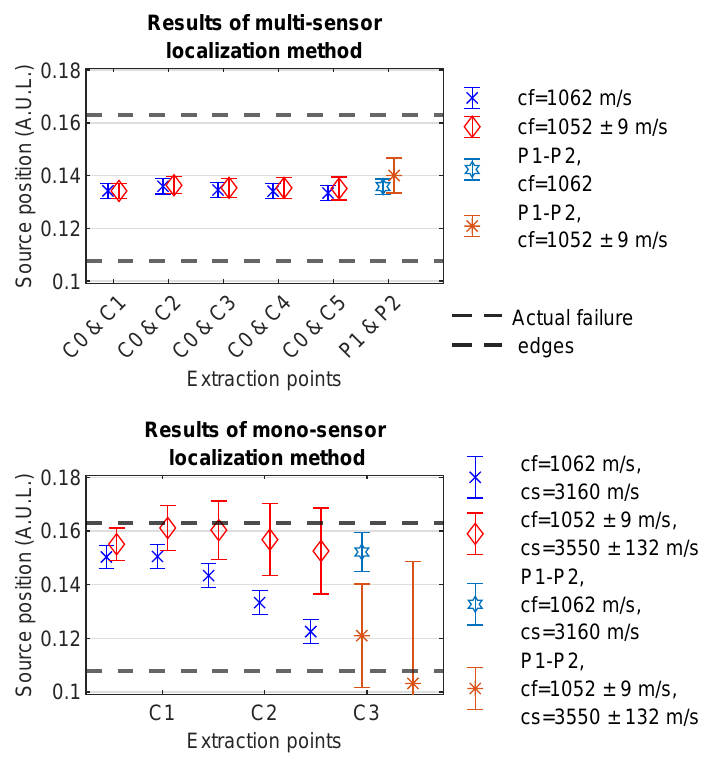
Figure 14. Results of the different methods for source localization (source position in arbitrary unit of length, defined as the length of the device main